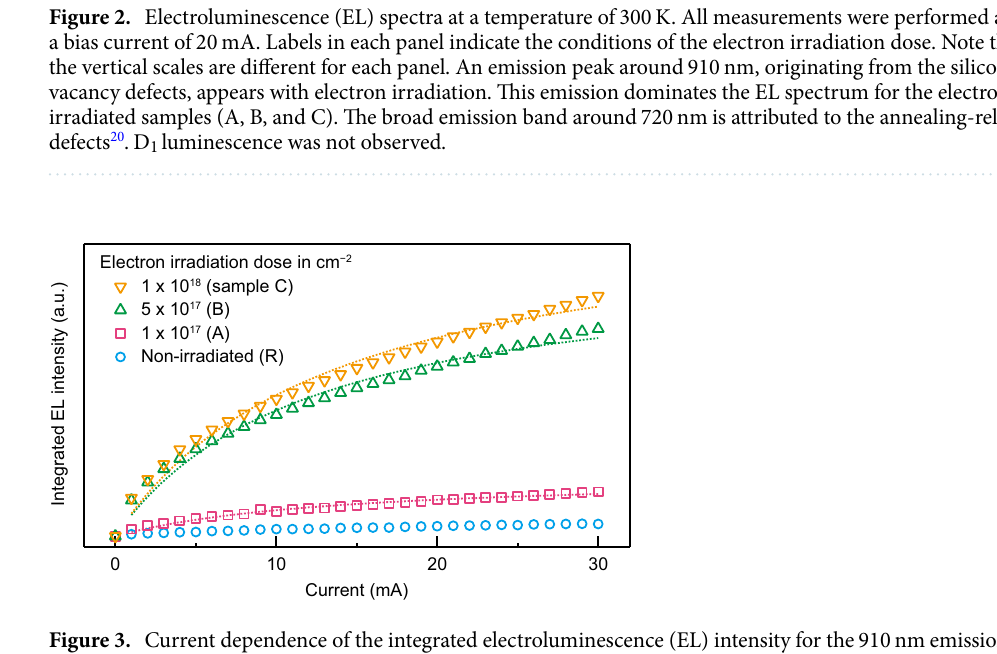
Figure 3. Current dependence of the integrated electroluminescence (EL) intensity for the 910 nm emission band. The integration range is fixed to 910 ± 60nm . Saturation of the integrated EL intensity is observed for the irradiated samples (A, B, and C). Dotted lines represent fits using the saturation-curve equation 23